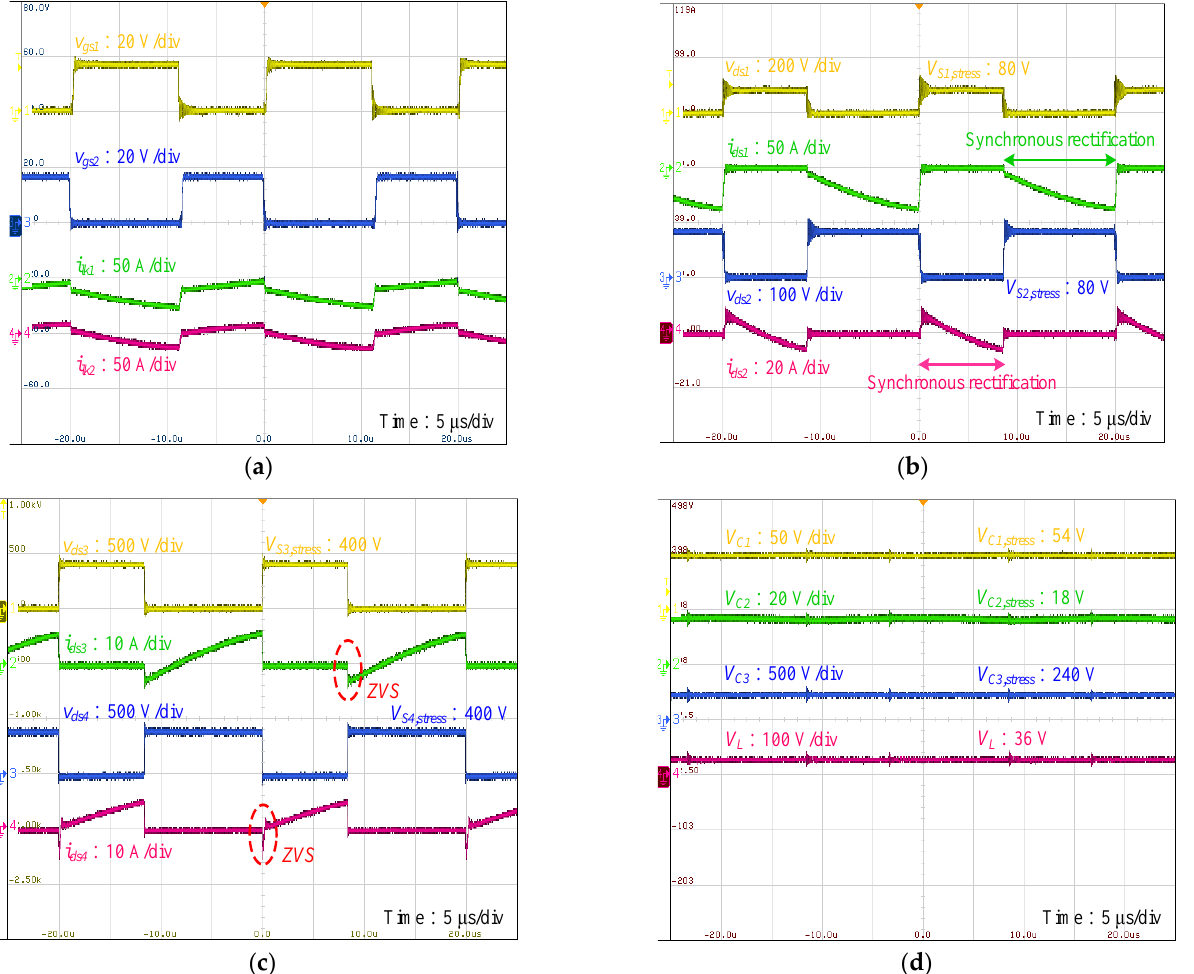
Figure 15. Experimental results of the proposed topology, operated in the step-down mode under the full load (500 W): ( a ) V gs 1 , V gs 2 , i lk 1 , and i lk 2 ; ( b ) V ds and i ds of S1 and S2; ( c ) V ds and i ds of S3 and S4; and ( d ) V C 1 , V C 2 , V C 3 , and V L .